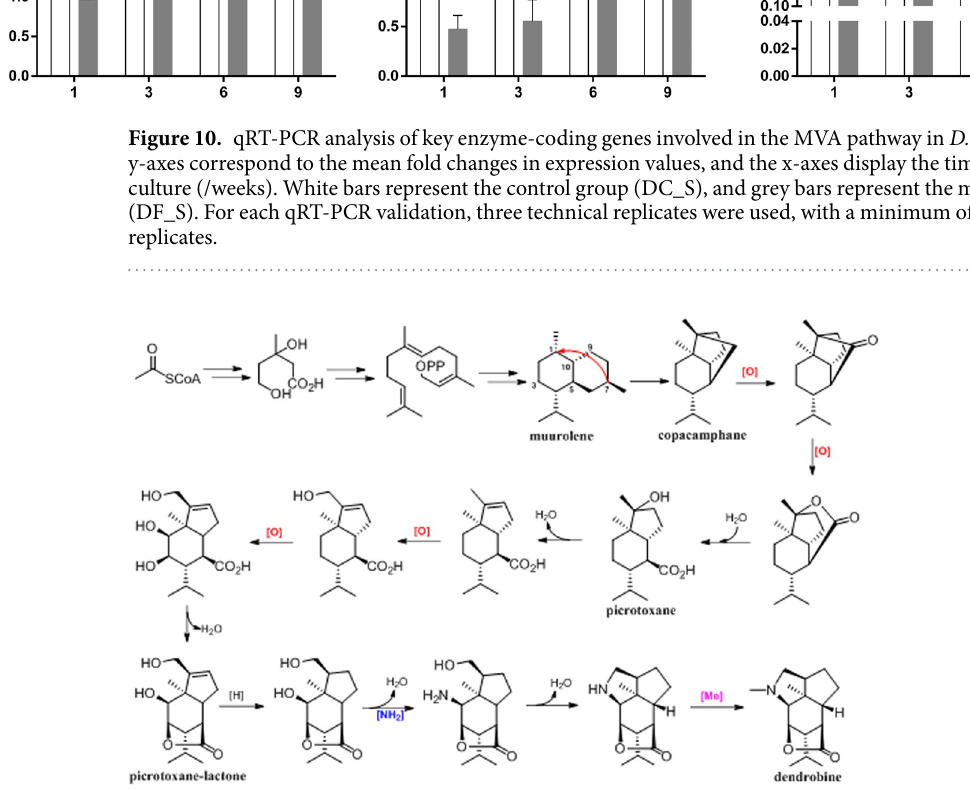
recent years, homologous genes of PMK and MVD have been cloned from Amomum villlosum , Ginkgo biloba , and Eleutherococcus senticosus 49–51 . A report proved that PMK was highly expressed in the roots of Aconitum